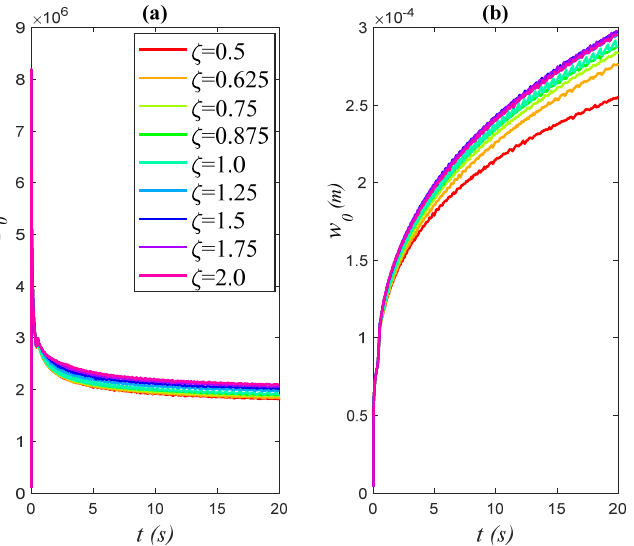
Figure 22. Evolution of the fluid pressure p 0 and the fracture opening w 0 at the wellbore under the proportion of pay zone 𝜉 = 1 9 ⁄ .